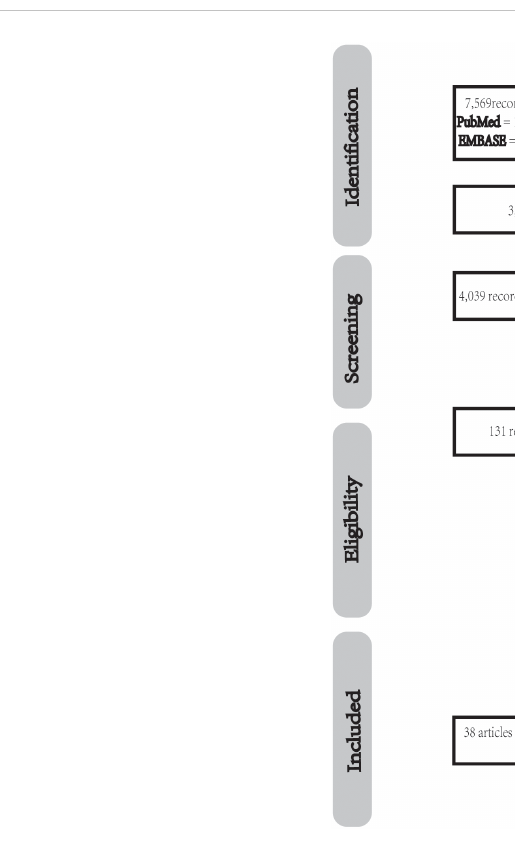
FIGURE 1 Flow chart of study identi fi cation, inclusion, and